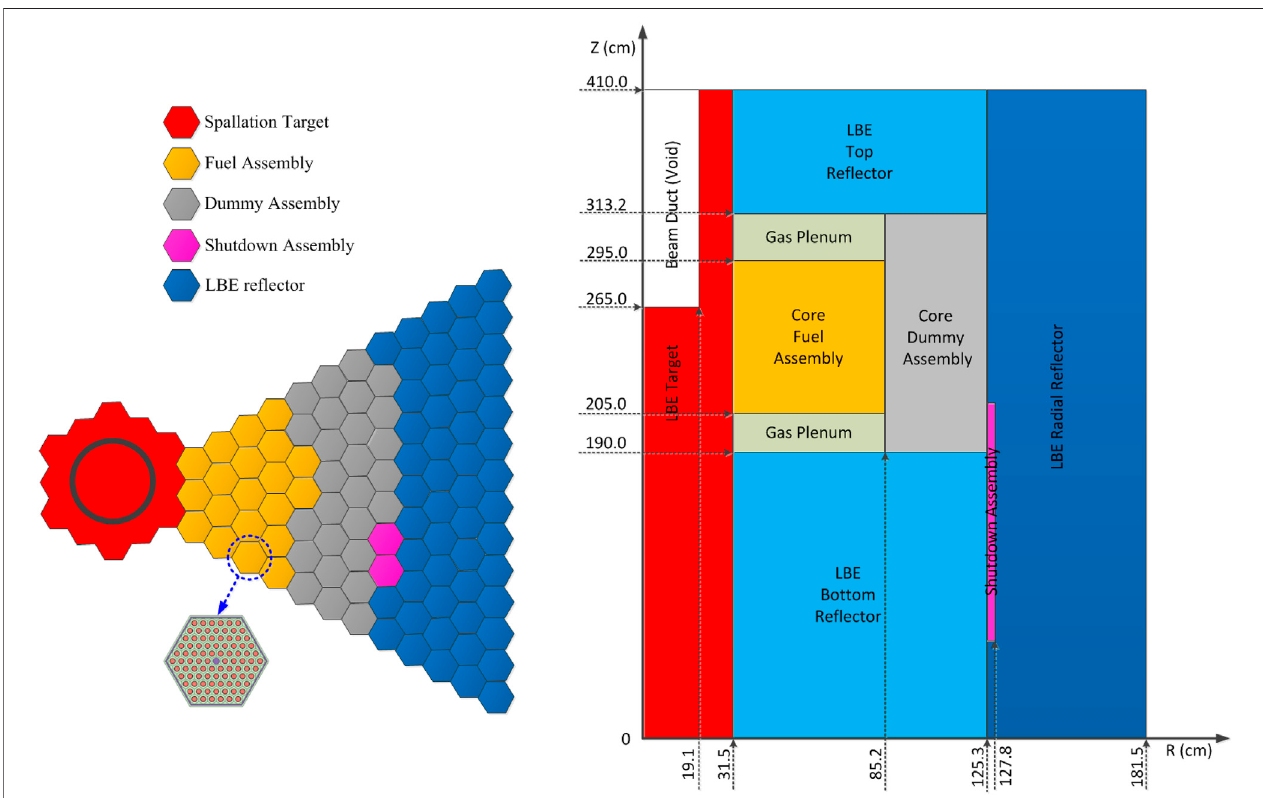
FIGURE 6 | Arrangement of assemblies and R – Z view of reactor model.